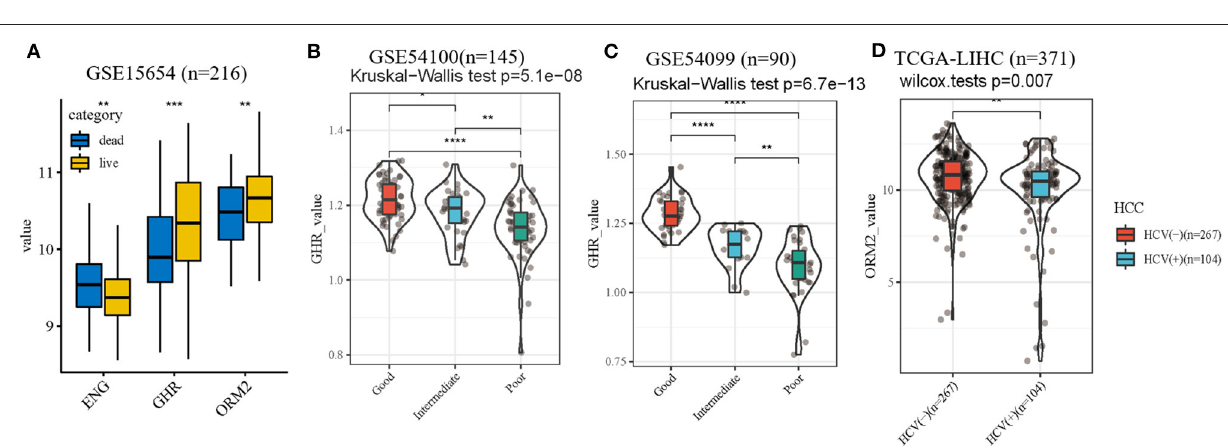
FIGURE 7 | Internal and external datasets verification. (A) expression levels of the three genes in patients with different survival status. (B,C) the association of GHR value with different clinical outcomes in external independent datasets. (D) different ORM2 value of HCC patients with HCV infection or not. * p < 0.05 ; ** p < 0.01 ; *** p < 0.001 ; **** p <